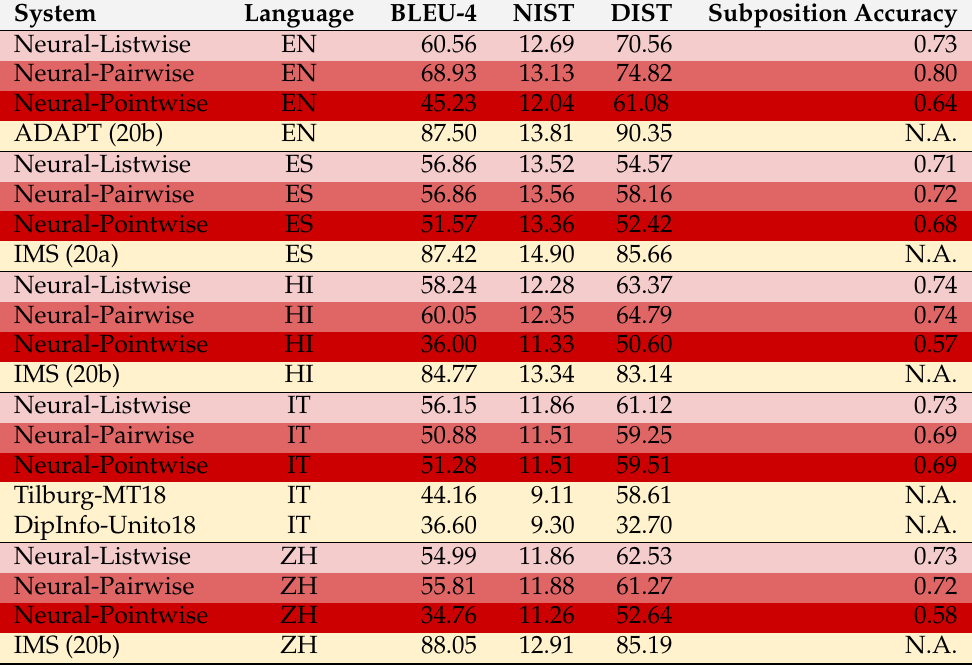
Table 6. The scores of the neural ranker system for English, Chinese, Hindi, Italian, and Spanish languages, in terms of the automatic metrics BLUE, NIST, and DIST and subposition